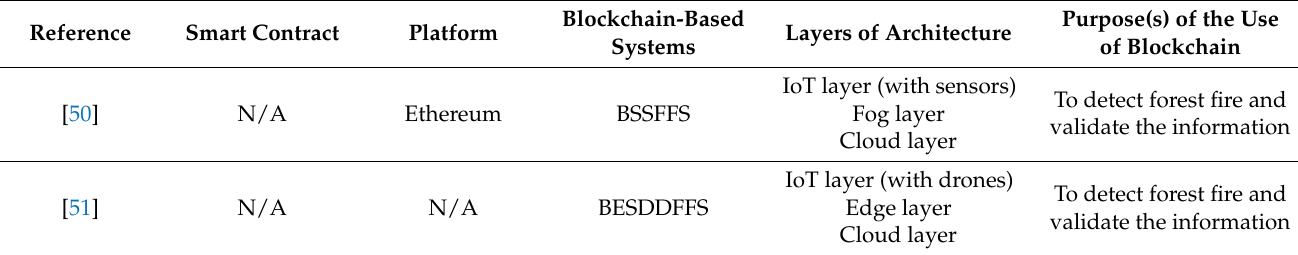
Table 4. Blockchain-based applications in the forest fire